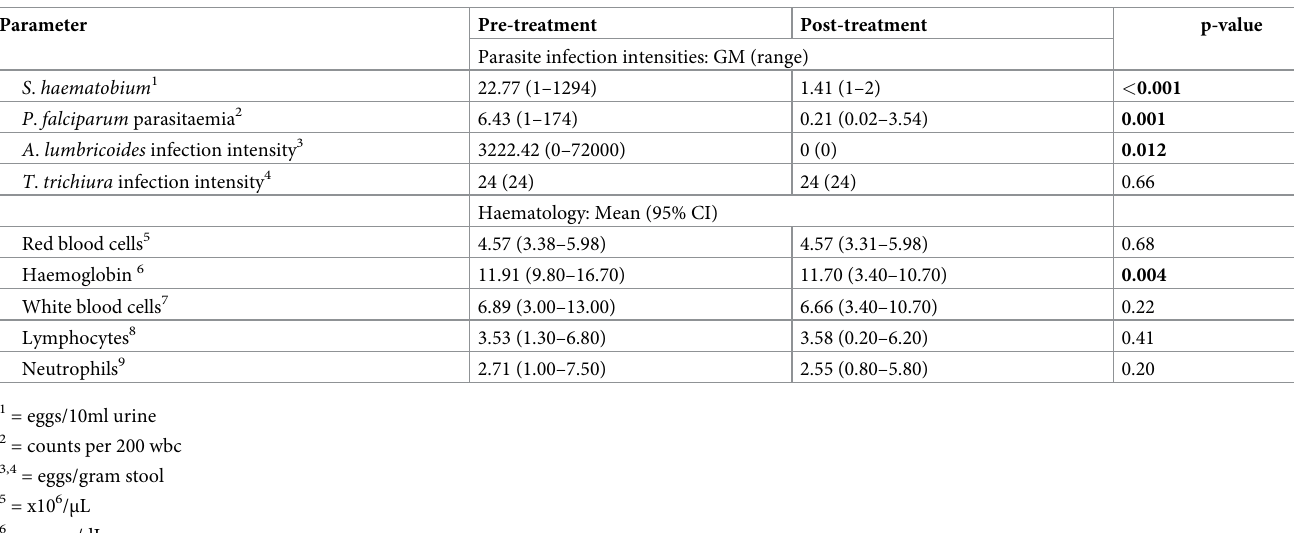
Assessment of questionnaire data on water contact information indicated firstly that 95 (83.33%) of the 114 participants relied on the stream/water body as their main source of water. Furthermore, 92 (80.70%) visited the water body regularly, with frequencies ranging between ‘once a month’ to ‘two or more times a day’. Of the 26 S . haematobium -positive cases recorded Table 2. Descriptive summary of interval parameters of